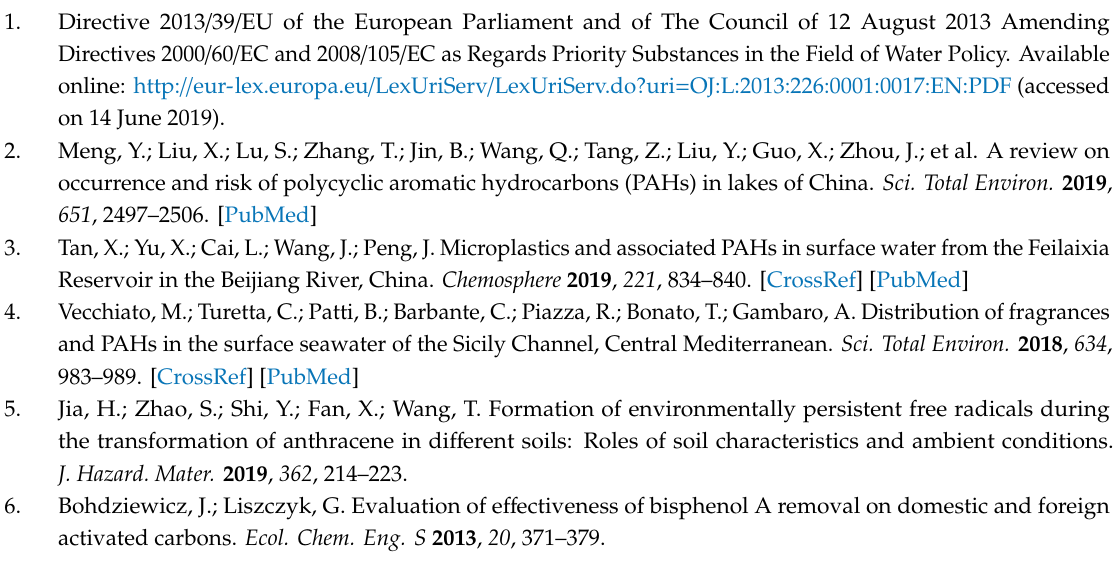
Figure S1: Digital photograph of Hal-SWCNT 85:15, Figure S2: EDX results of Hal-CNT composites, Figure S3: ATR-FTIR spectra of: (a) SWCNT (b)